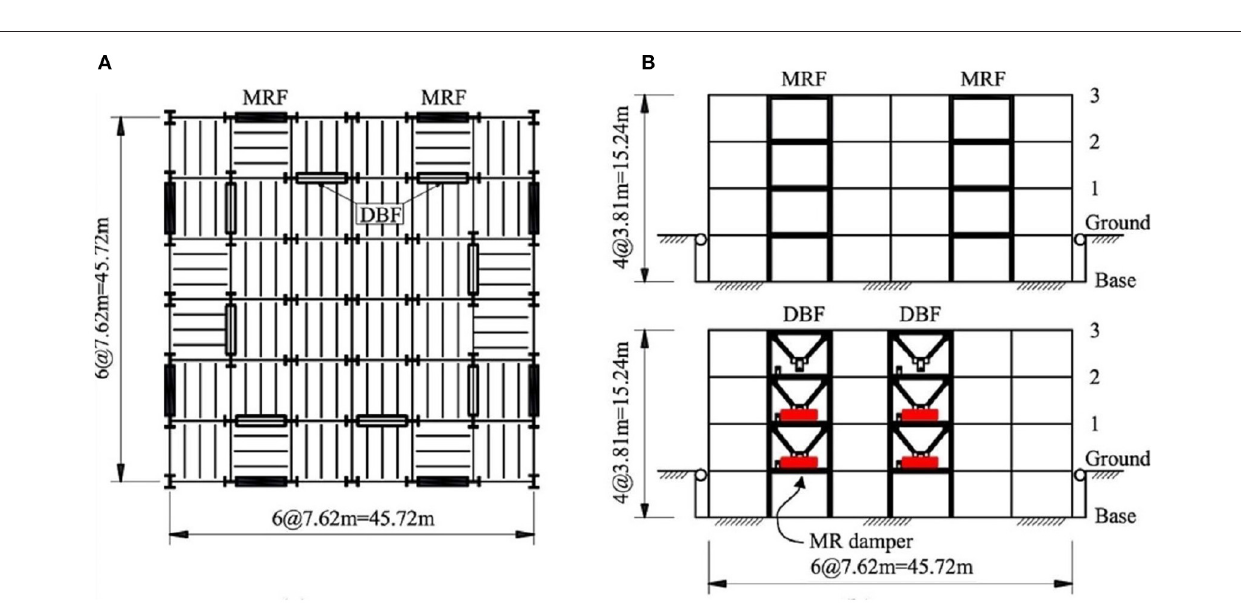
masses, were modeled via the analytical substructure, as shown in Figure 6C